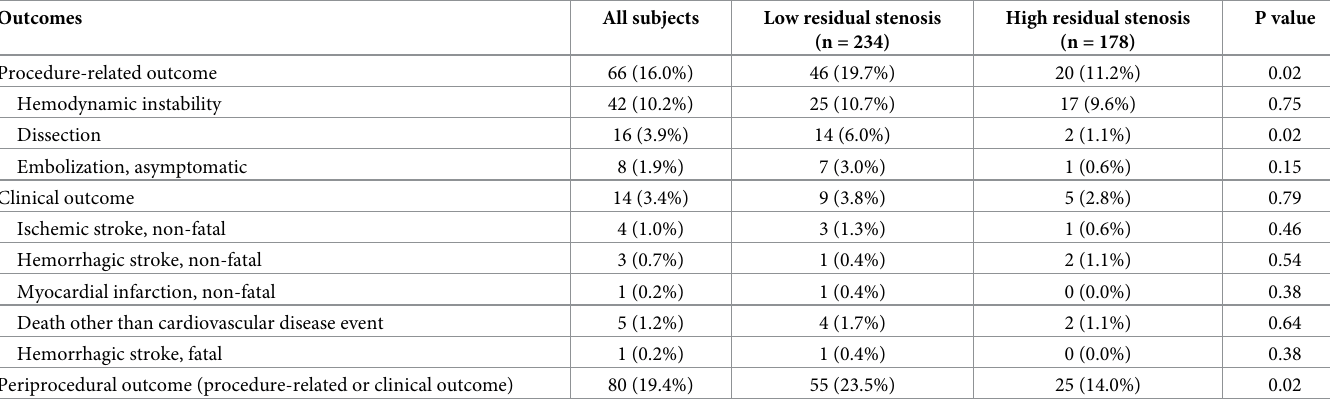
Table 2. Periprocedural outcome and residual stenosis.